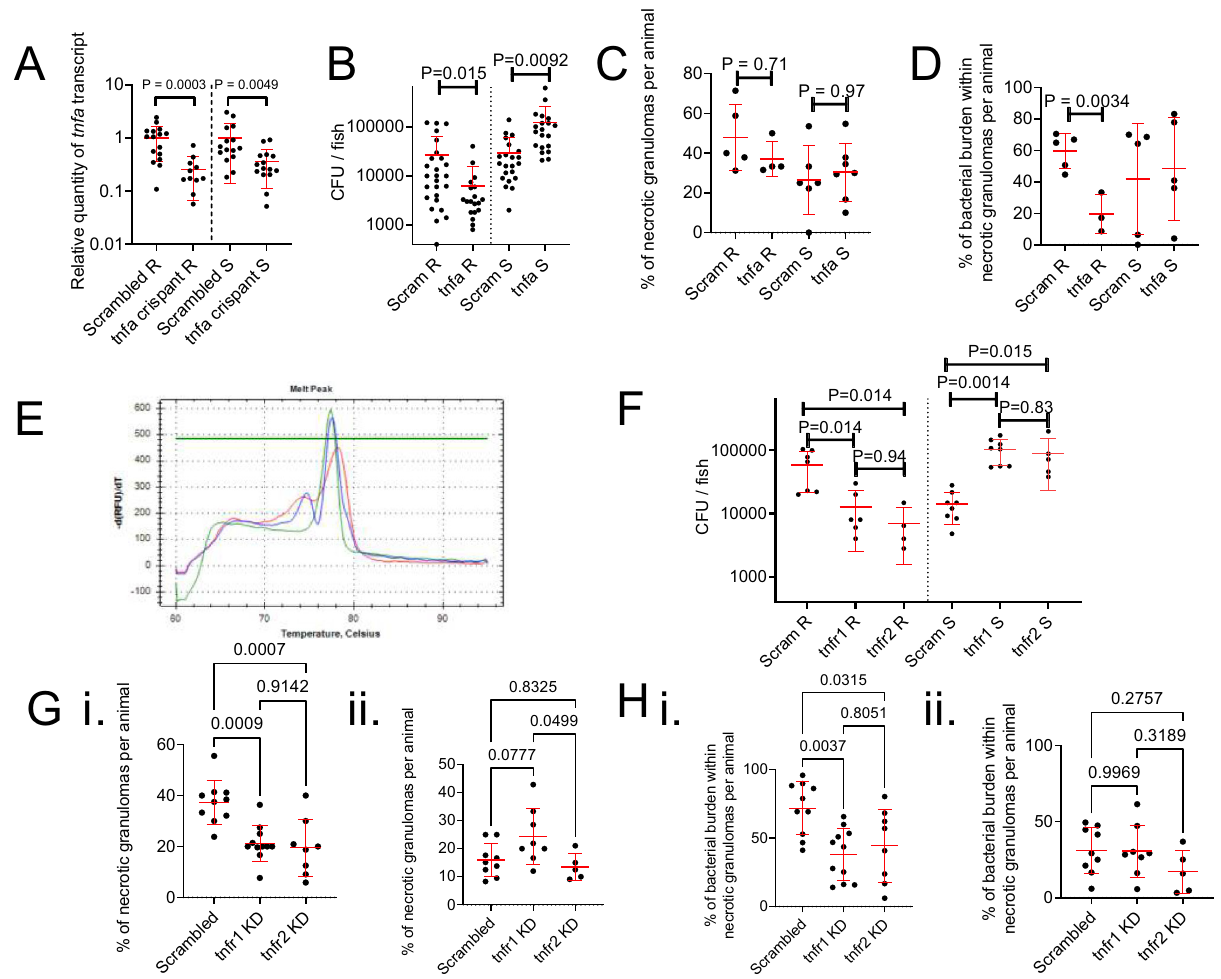
Fig. 4 Host TNF drives M. abscessus R granuloma expansion and control of M. abscessus S infection. A Quanti fi cation of tnfa transcripts activity in 14 dpi zebra fi sh injected with scrambled control or tnfa -targeting gRNA-Cas9 complexes. Each data point represents a single animal, data are pooled from 2 biological replicates, total number of animals: Scrambled R = 16, tnfa crispant R = 11, Scrambled S = 15, tnfa crispant S = 15. Statistical testing by two- sided Student ’ s t test within each of the independent R and S experiments. B Enumeration of CFUs from tnfa crispant adult zebra fi sh infected with 10 4 CFU of either the R or the S variant of M. abscessus . Each data point represents a single animal, data are pooled from 3 biological replicates, total number of animals: Scrambled R = 26, tnfa crispant R = 19, Scrambled S = 22, tnfa crispant S = 20. Statistical testing by two-sided Student ’ s t test within each of the independent R and S experiments. C Quanti fi cation of bacterial lesion necrosis in tnfa crispant adult zebra fi sh infected with M. abscessus . Each data point represents the proportion of lesions from a single animal. Statistical testing by two-sided ANOVA. D Quanti fi cation of bacterial burden strati fi ed by lesion necrosis in tnfa crispant adult zebra fi sh infected with M. abscessus . Each data point represents the proportion of lesions from a single animal. Total individual lesions and animals analysed in C , D (necrotic/unorganised/animals): Scrambled R (43/51/5); tnfa crispant R (12/21/3); Scrambled S (25/43/ 5); tnfa crispant S (57/96/5). Statistical testing by two-sided ANOVA. E Example of high resolution melt analysis of the fi rst tnfr2 CRISPR target site in 14 dpi zebra fi sh injected with scrambled control (blue), tnfr1 (green), or tnfr2 (red)-targeting gRNA-Cas9 complexes. F Enumeration of CFUs from tnfr1 and tnfr2 crispant adult zebra fi sh infected with 10 4 CFU of either the R or the S variant of M. abscessus . Each data point represents a single animal, data are representative of 3 biological replicates. Statistical testing by two-sided ANOVA within each of the independent R and S experiments. Total number of animals (Scram/tnfr1/tnfr2): R = 7/6/4, S = 8/8/5. G Quanti fi cation of bacterial lesion necrosis in tnfr1 and tnfr2 crispant adult zebra fi sh infected with M. abscessus . Each data point represents the proportion of lesions from a single animal. H . Quanti fi cation of bacterial burden strati fi ed by lesion necrosis in tnfr1 and tnfr2 crispant adult zebra fi sh infected with M. abscessus . Each data point represents the proportion of lesions from a single animal. Total individual lesions and animals analysed in G , H (necrotic/unorganised/animals): Scrambled R (91/224/10); tnfr1 crispant R (89/308/11); tnfr2 crispant R (40/173/ 8); Scrambled S (25/139/9); tnfr1 crispant S (40/143/8); tnfr2 crispant S (17/97/5). Statistical testing by two-sided ANOVA. Data are presented as mean values ± SD. Source data are provided as a Source Data fi